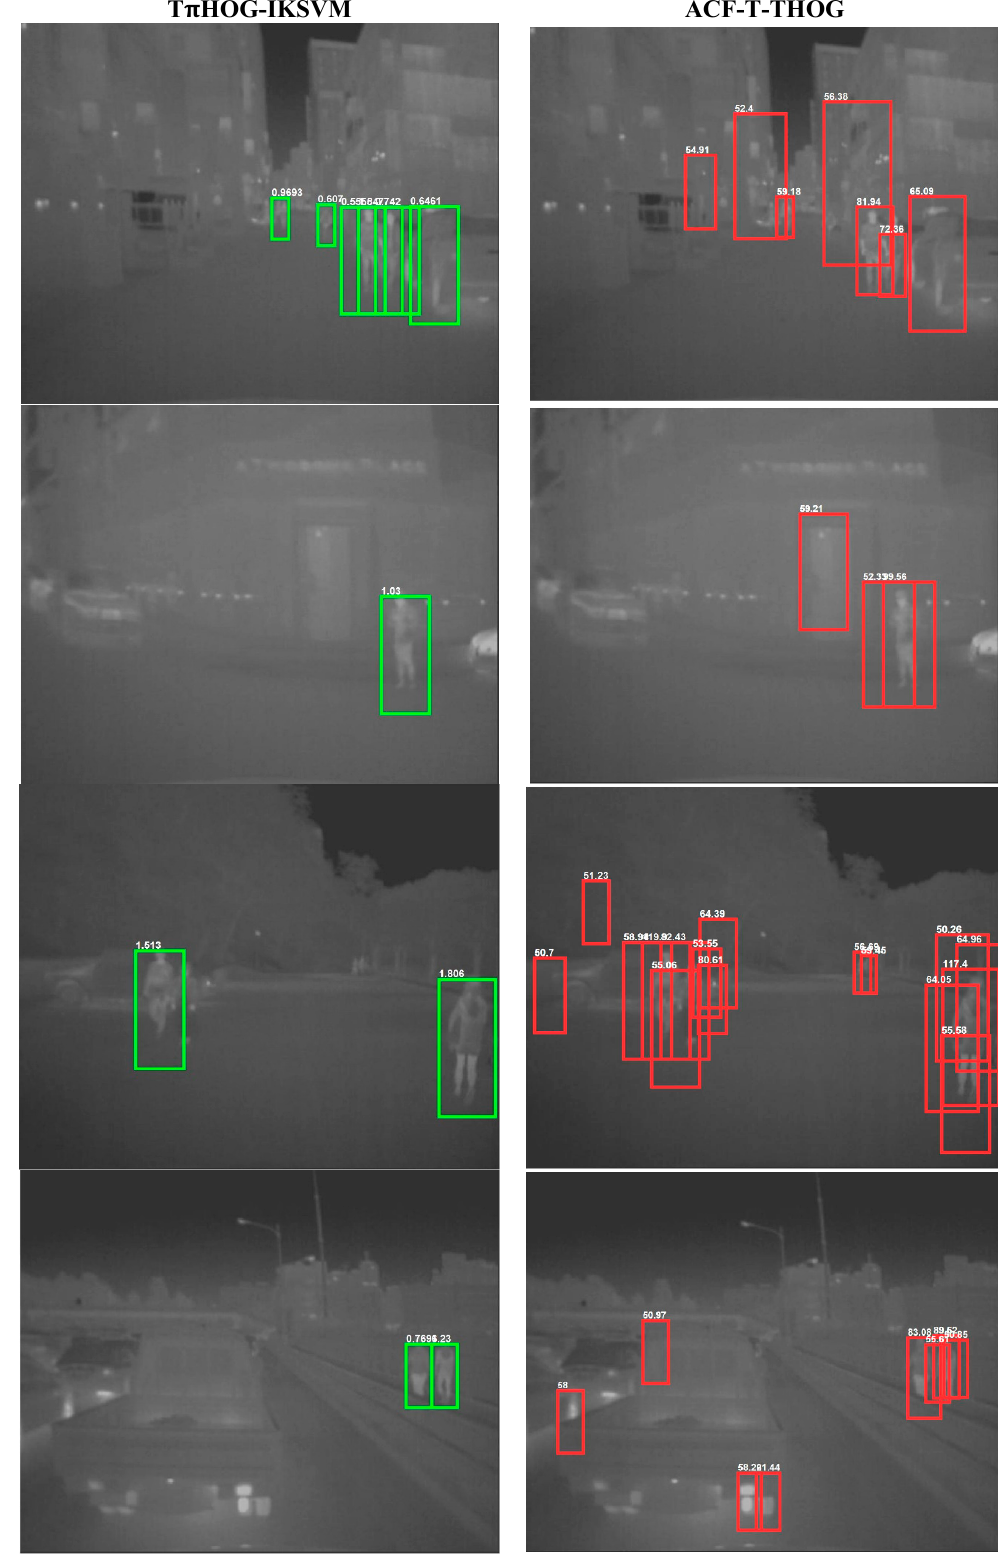
Figure 19. Detection results on test images of KAIST DB.